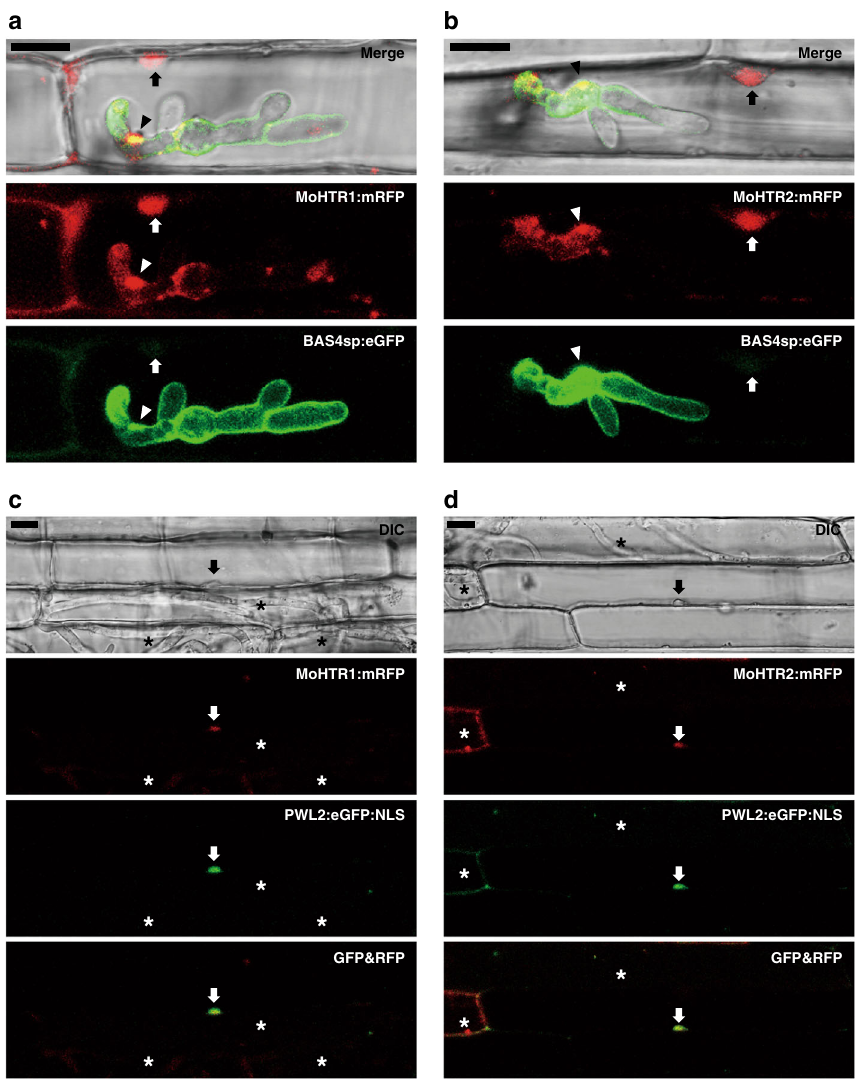
Fig. 2 Translocation of MoHTR1 and MoHTR2 into rice cell and migration into rice nuclei. The MoHTR1:mRFP and MoHTR2:mRFP expressed under control of their native promoter were observed at an early infection stage (30 hpi). BAS4sp:eGFP is a marker for intact extra-invasive hyphal membrane. a MoHTR1:mRFP and b MoHTR2:mRFP were mainly localized in BICs and the nuclei of invaded rice leaf sheath cells. The images shown were chosen from confocal optical z-sections taken at 1- μ m intervals. At 48 hpi, c MoHTR1:mRFP and d MoHTR2:mRFP were also detected in the nuclei of some uninfected cells. Arrowheads indicate BICs, and arrows indicate rice nuclei. Asterisks indicate rice cells invaded by fungal hyphae. Scale bars = 10 μ m. Representative micrographs are shown from three independently infected rice sheaths and additional representative data are provided as a Source Data fi